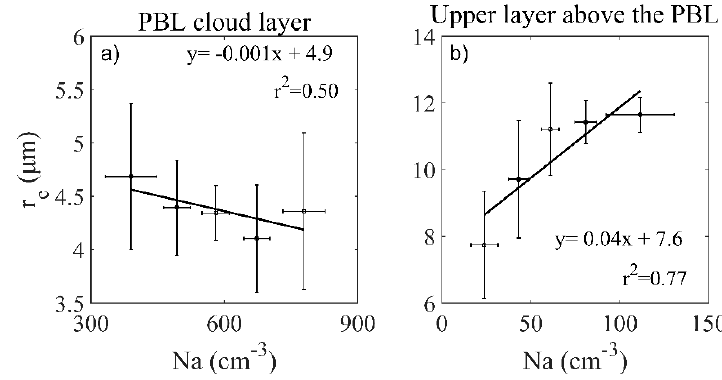
Figure 4. Relationship between cloud droplet re and aerosol Na for ( a ) the PBL cloud layer, and ( b ) upper layer above the PBL. The circles and bars represent the means and standard deviations of the examined variables (re and Na) at each bin of Na. The five bins are classified based on Na with the same sample volume, which are 260–446 cm − 3 , 460–540 cm − 3 , 540–618 cm − 3 , 626–705 cm − 3 , and 714–855 cm − 3 for the PBL cloud layer, and 8–35 cm − 3 , 35–53 cm − 3 , 54–69 cm − 3 , 70–93 cm − 3 , and 93–190 cm − 3 for the upper layer above the PBL. The fitting lines are all linearly regressed based on the bin averages of Na and r e .